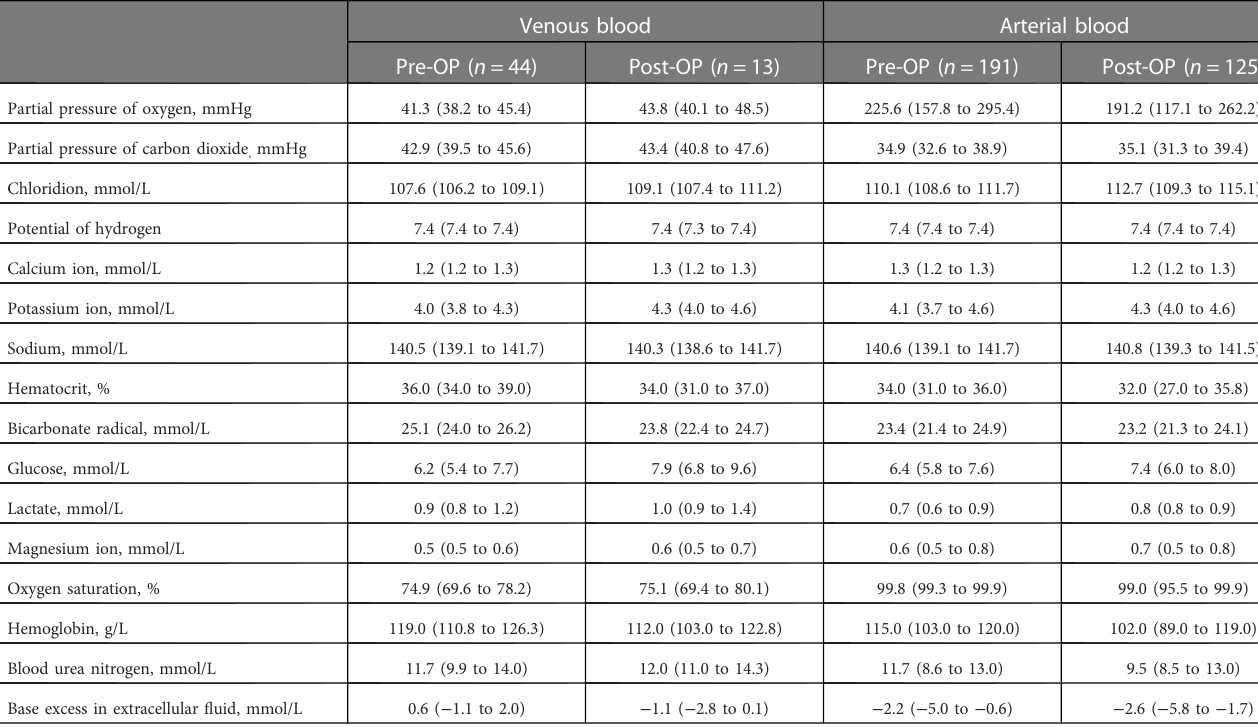
TABLE 3 Blood gas analysis.